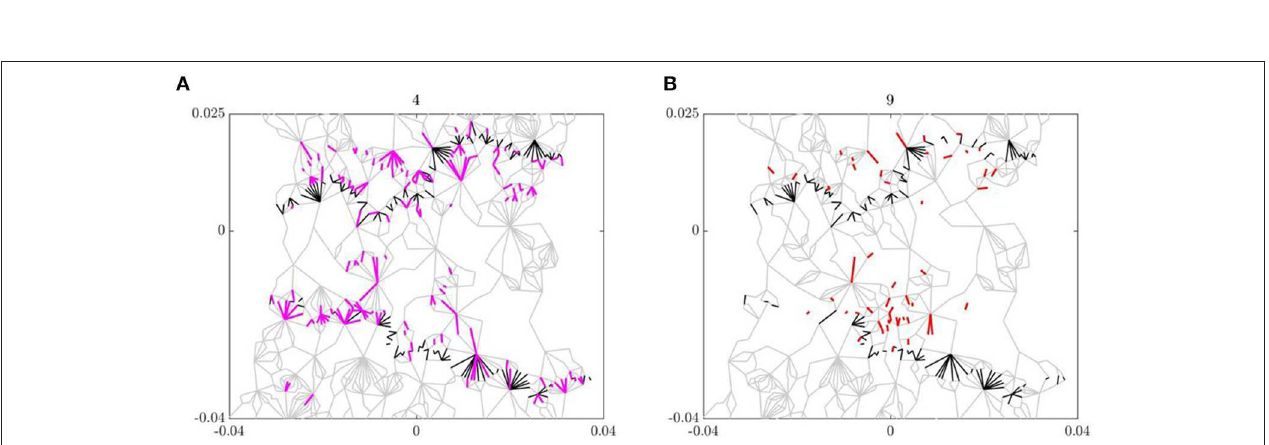
FIGURE 12 | (Color online) Loss of global force transmission capacity and force reroutes in P . (A,C,E) DI and (B,D,F) DII. (A,B) Evolution of the reroute score R re and | 1 F ∗ | : inset shows the evolution of the population of no access and replacement links. Population of no access, replacement, and damaged links across the preceding stage [ ǫ − 1, ǫ ]: (C,D) in B ∗ and the secondary bottleneck (inset); and (E,F) in the mobile links outside of bottleneck. Dashed vertical line marks the stage at peak load.